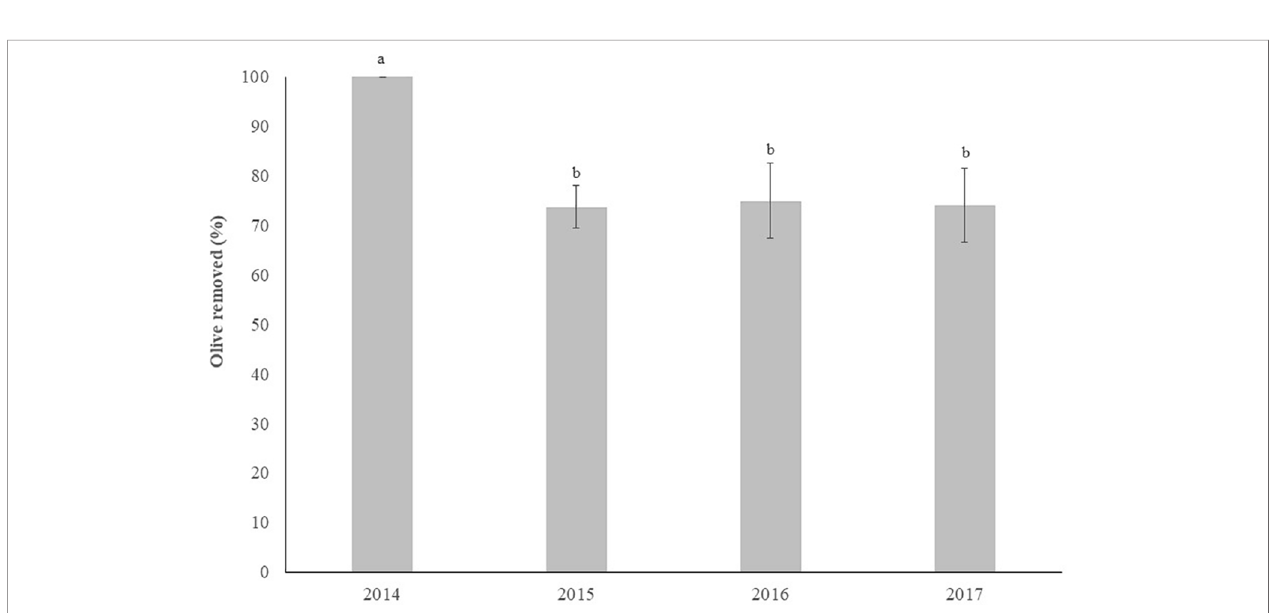
FIGURE 12 | Effect of year in the harvester ef fi ciency (mean±sd). Columns followed by the same letter are not signi fi cantly different by Duncan multiple range test at the 5%